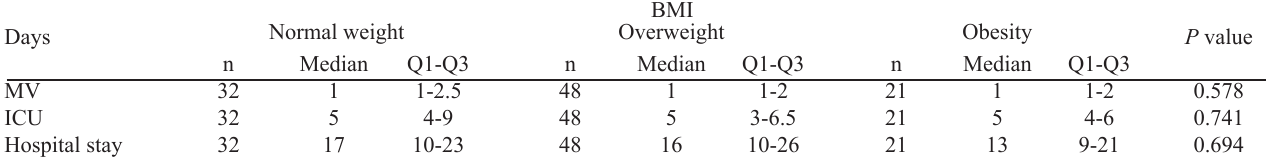
Table 3. Comparison of MV, ICU, and hospital stay postoperative times from patients undergoing heart surgery.